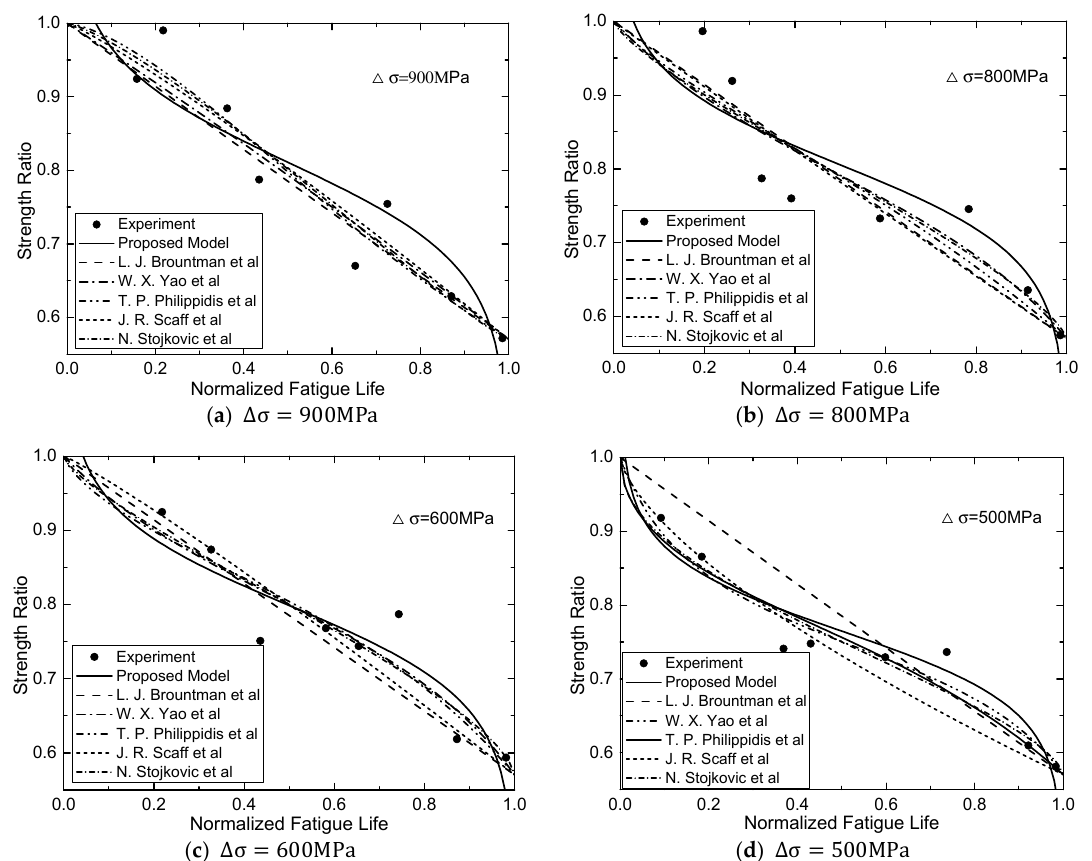
Figure 5. Predictions of residual strength models and measurements of CFRP tendons at different stress ranges: ( a ) ∆σ = 900MPa, ( b ) ∆σ = 800MPa, ( c ) ∆σ = 600MPa, ( d ) ∆σ = 500MPa.